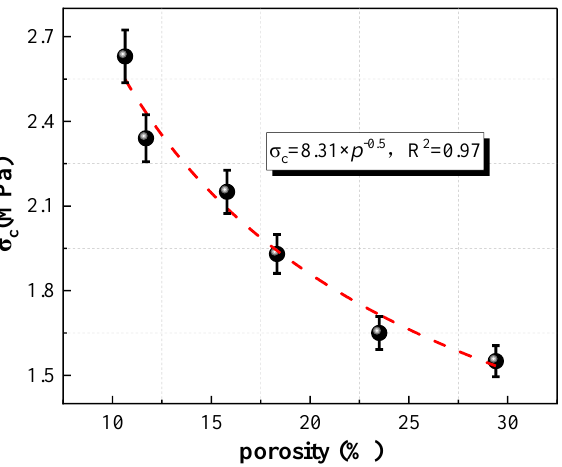
Figure 10. Relationship between uniaxial compressive strength and porosity.